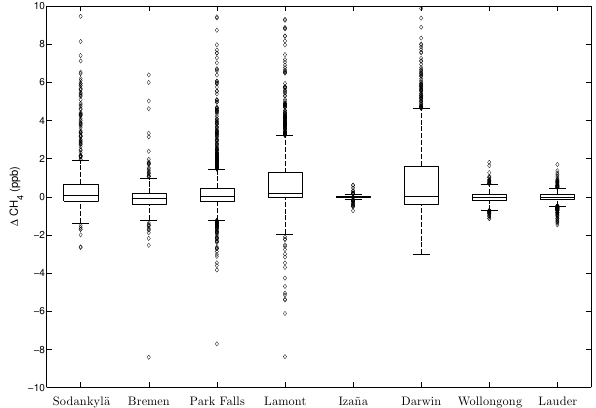
Figure 6. The differences between daily tropospheric CH 4 standard deviations using the Washenfelder et al. (2003) and updated meth- ods. (Positive values correspond to larger Washenfelder et al. (2003) standard deviations.) Box ends, midline and whiskers illustrate the quartiles, medians and twice the interquartile ranges, respectively. Outliers beyond the the range are denoted by diamonds.